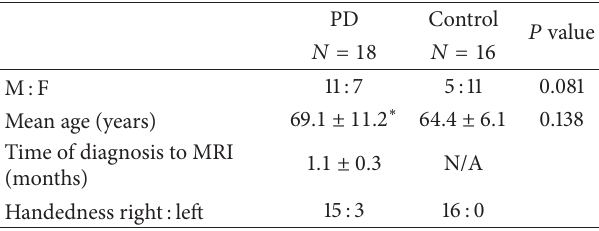
Table 1: Demographic and clinical characteristics of the study